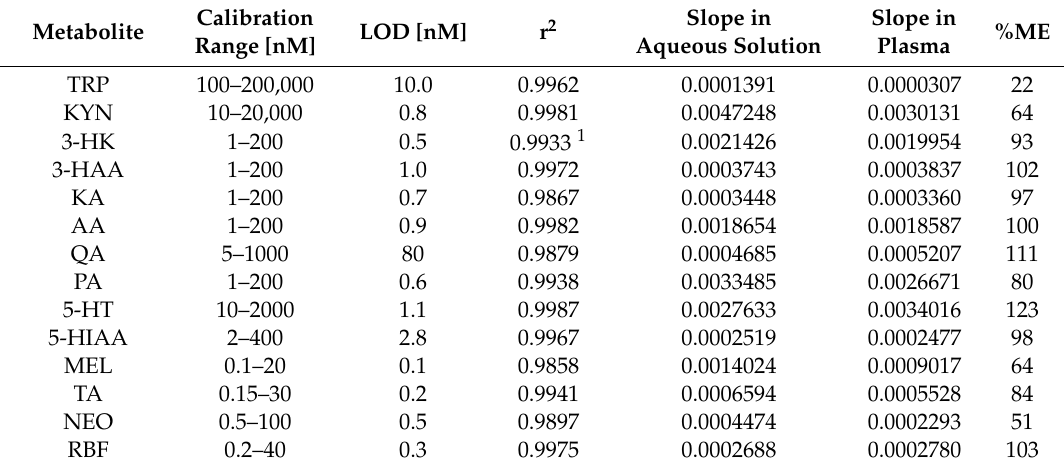
Table A2. Calibration parameters and matrix e ff ects in plasma